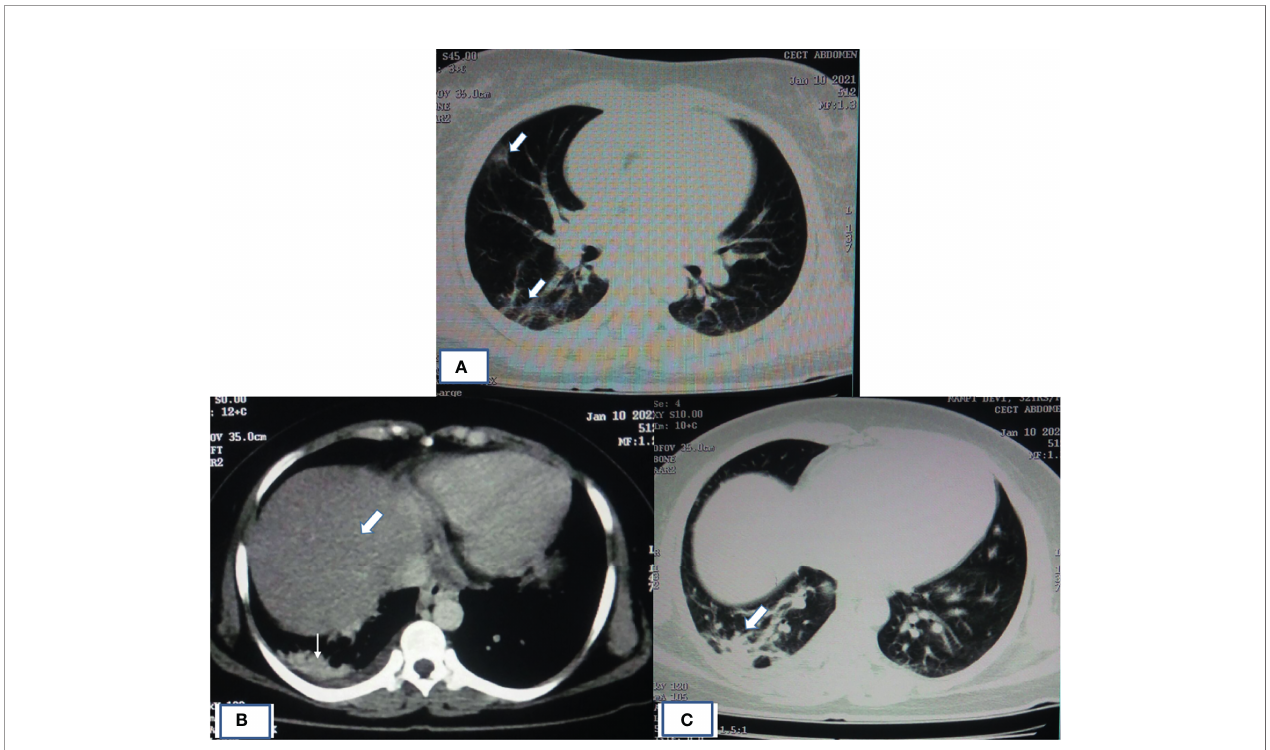
FIGURE 3 | HRCT of patient showing typical imaging manifestations of COVID-19 pneumonia and fatty in fi ltration of liver. (A) HRCT of chest showing pneumonia in the form of peripheral, multifocal consolidative and ground-glass opacities as indicated by thick white arrow. (B) Mediastinal window image of same COVID-19 patient with altered LFT had shown fatty in fi ltration of liver (thick white arrow) with opacity in the right lung base (thin white arrow). (C) Corresponding lung window image showing ground-glass haziness of COVID-19 pneumonia (thick white